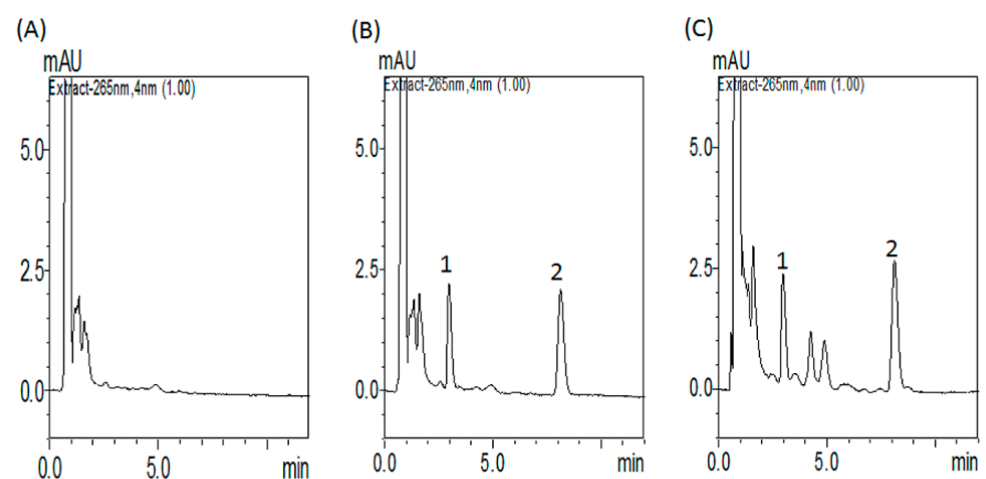
Figure 2. HPLC–UV chromatograms of ( A ) blank plasma samples; ( B ) blank plasma samples spiked with regorafenib (1 µ g/mL) and internal standard (IS, 0.8 µ g/mL); and ( C ) regorafenib (1.5 µ g/mL) and internal standard (IS) (0.8 µ g/mL) collected 180 min after regorafenib (16 mg/kg, p.o.) administration alone. Peak 1: internal standard, diethylstilbestrol. Peak 2: regorafenib. The retention time of regorafenib was 8.1 min, with good separation and no endogenous interference in the rat plasma samples, and the procedure exhibited good selectivity.